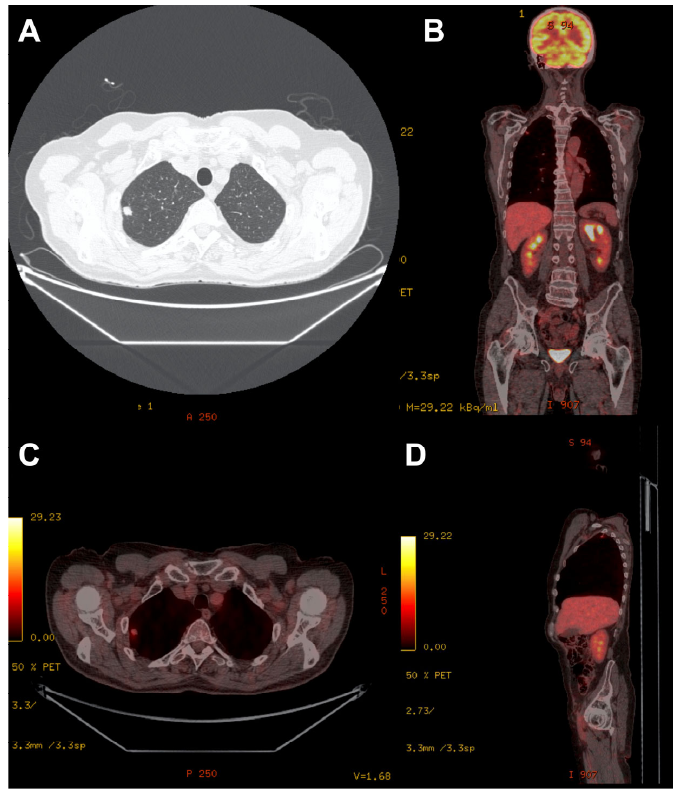
Figure 1. ( A ) Chest CT with a nodule in the right lung. ( B ). PET ‐ CT coronal view. ( C ). PET ‐ CT axial view. ( D ). PET ‐ CT sagittal view. An 11 mm nodule is present in the second segment of the right lung, with a standardized uptake value of 2.45.